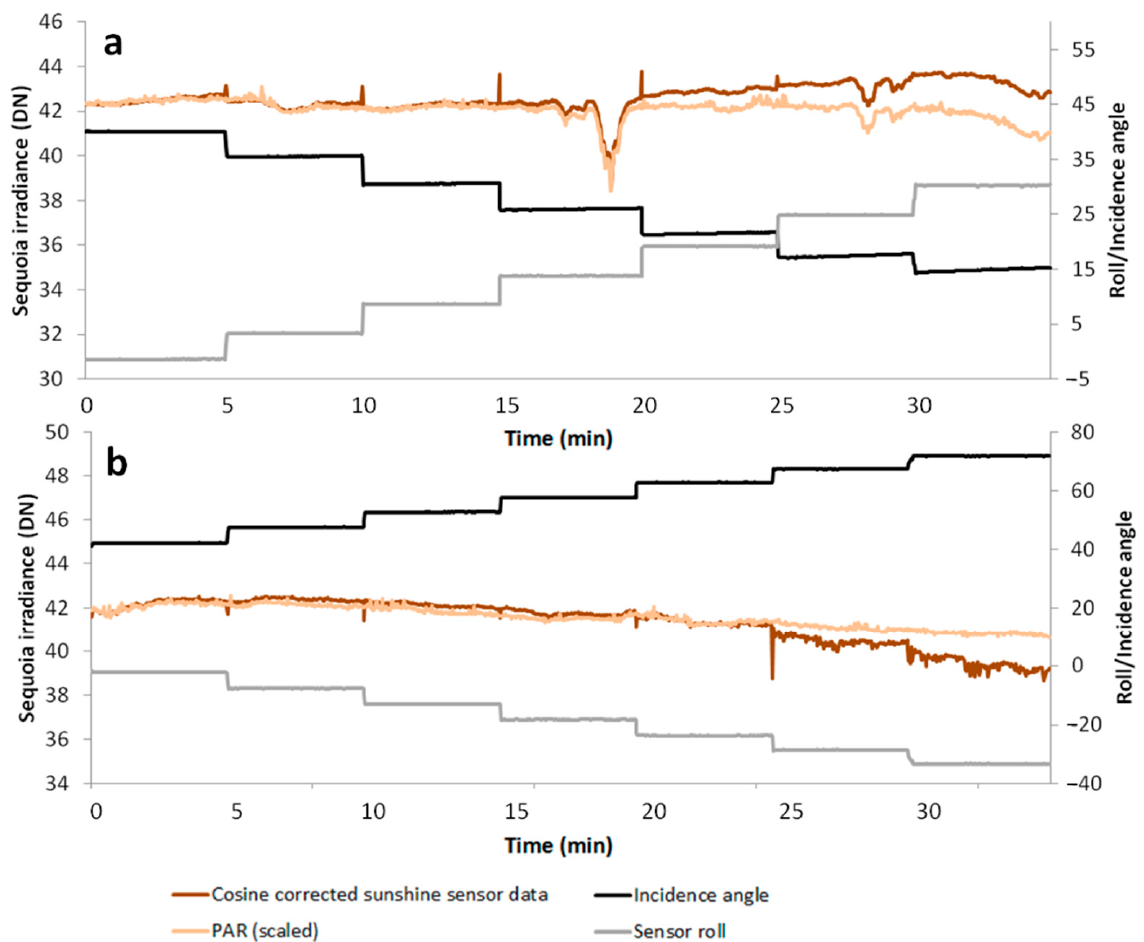
Figure 8. Cosine-corrected irradiance in the green wavelength band from the sunshine sensor (brown) and PAR (beige) measured with a horizontally mounted PAR sensor. Incidence angle for the sunshine sensor is shown in black and the roll is shown in gray. The sensor was rotated toward the south (decreasing incidence angles) in ( a ) and toward the north (increasing incidence angles) in ( b ). Data were collected in sunny conditions.